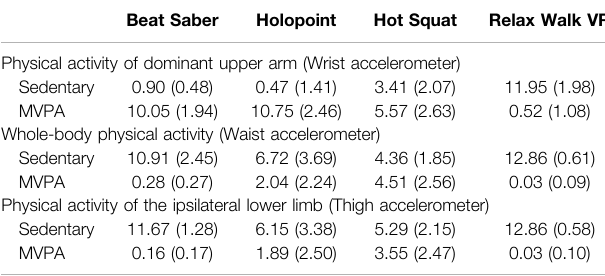
TABLE 4 | Means and standard deviations (SD) for accelerometer variables (time spent [minutes]) for each game and body